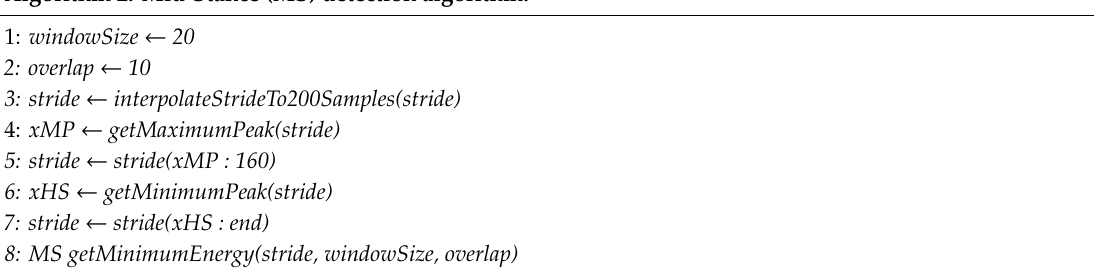
Algorithm 2: Mid-Stance (MS) detection